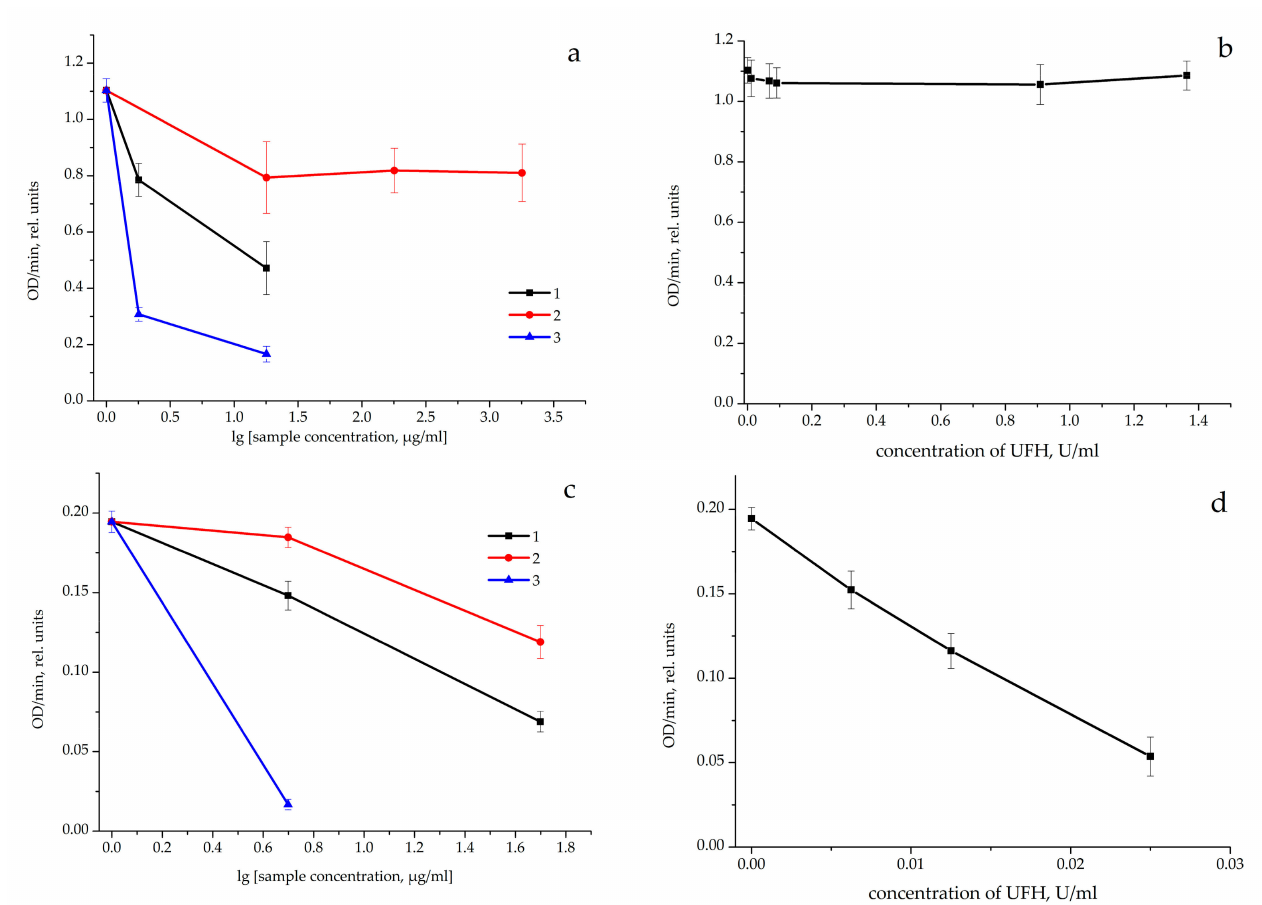
Figure 3. Effect of ( a , c ) the GGM/GM sulfates and ( b , d ) UFH on the optical density variation (OD/min, rel. units) of the solution containing ( a , b ) thrombin and chromogenic substrate ( n = 3–4) or ( c , d ) thrombin, antithrombin, and chromogenic substrate ( n = 3–6). (1) SGGM, (2) SGM-1, and (3)